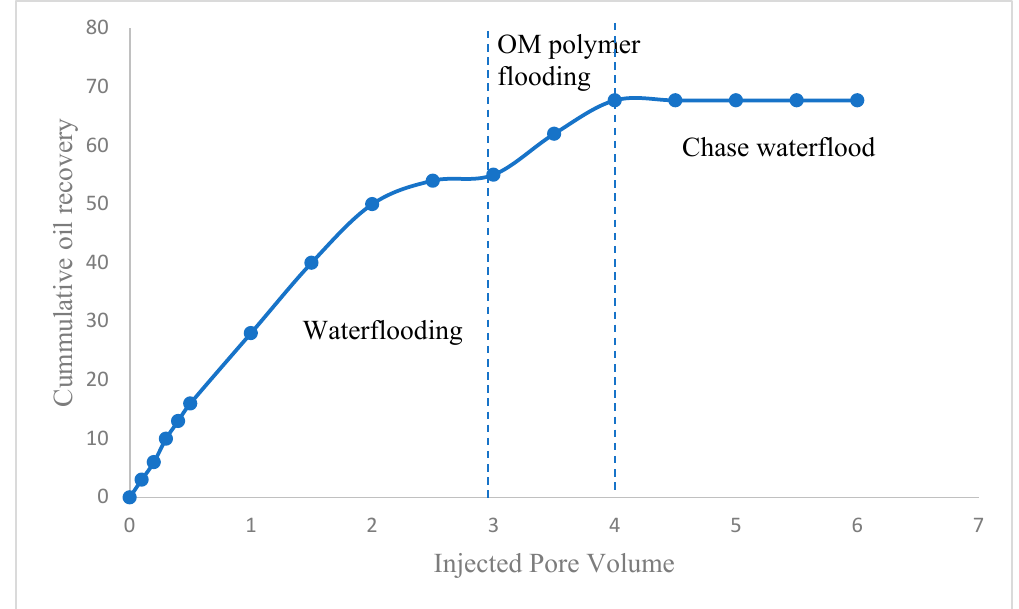
Figure 9. Cumulative oil recovery versus injected pore volume.